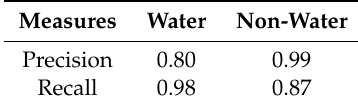
Table 9. Precision and recall of permanent water extraction